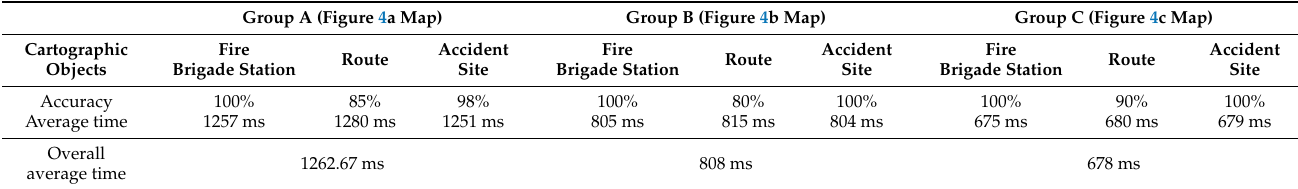
Table 4. The experimental accuracy and reaction time for each group.